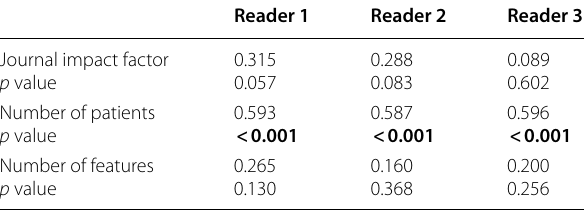
Numbers represent the Spearman’s rank correlation coefficient (ρ), unless otherwise specified. Statistically significant values ( p < 0.05) are highlighted